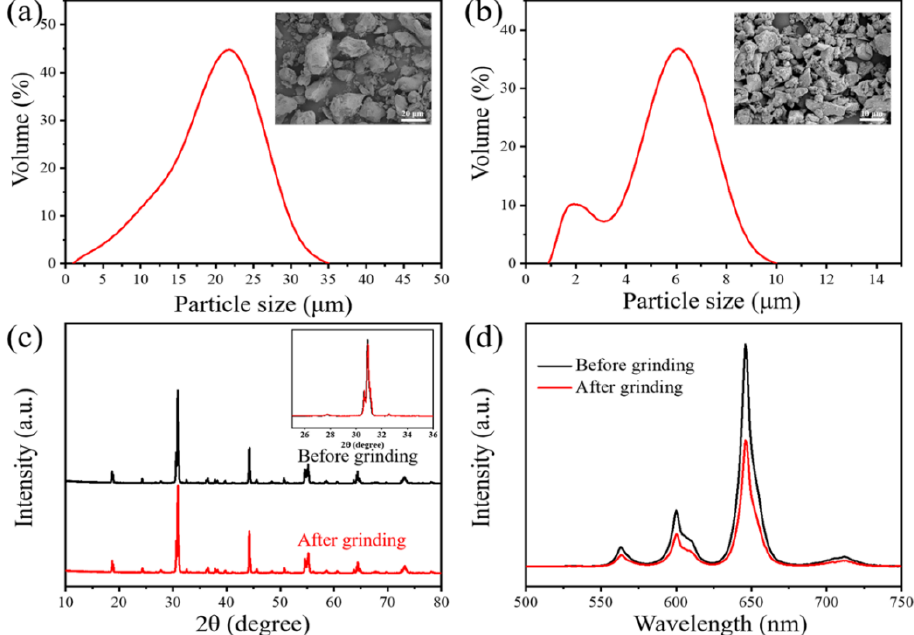
Figure 5. ( a ) The initial particle size distribution of Sm25Na25. ( b ) Particle size distribution of Sm25Na25 after grinding. ( c ) XRD spectra before and after grinding. ( d ) Emission spectra before and after grinding.